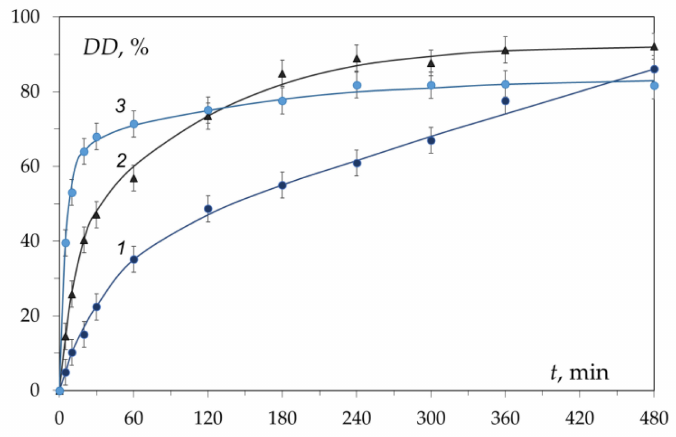
Figure 12. Kinetic curves of heterogeneous alkaline deacetylation at 100 ◦ C. Solution concentrations (mol/dm 3 ): NaOH, 13.48 (1), KOH, 13.48 (2), and NaOH, 19.34 (3). The mass ratio of chitin and solution is 1:55. Original figure.